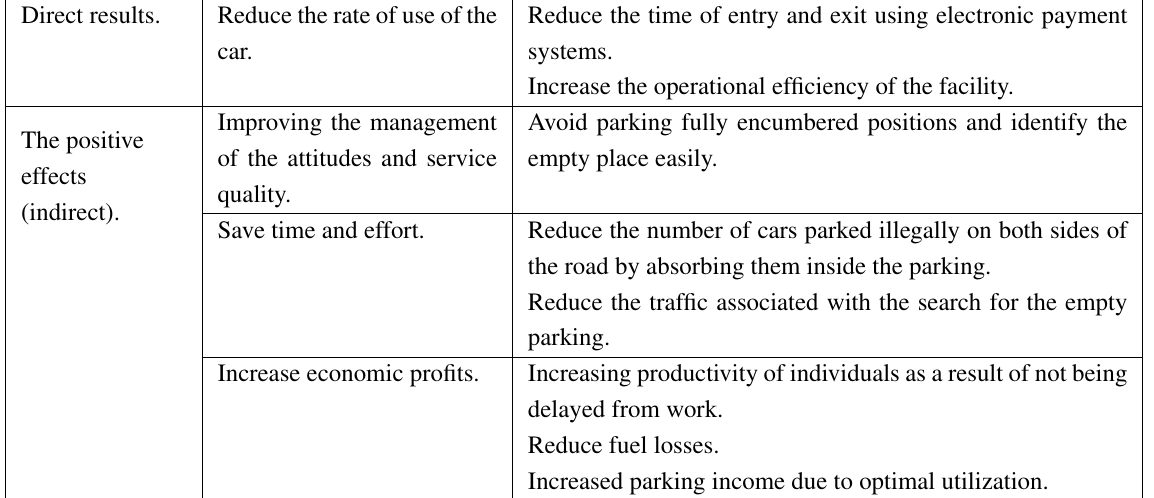
Table 4. Results of E-parking system and the positive effects. (Adeeb,